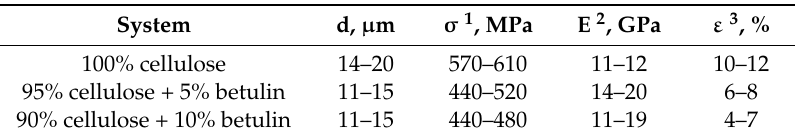
Table 1. Mechanical properties of the cellulose and composite